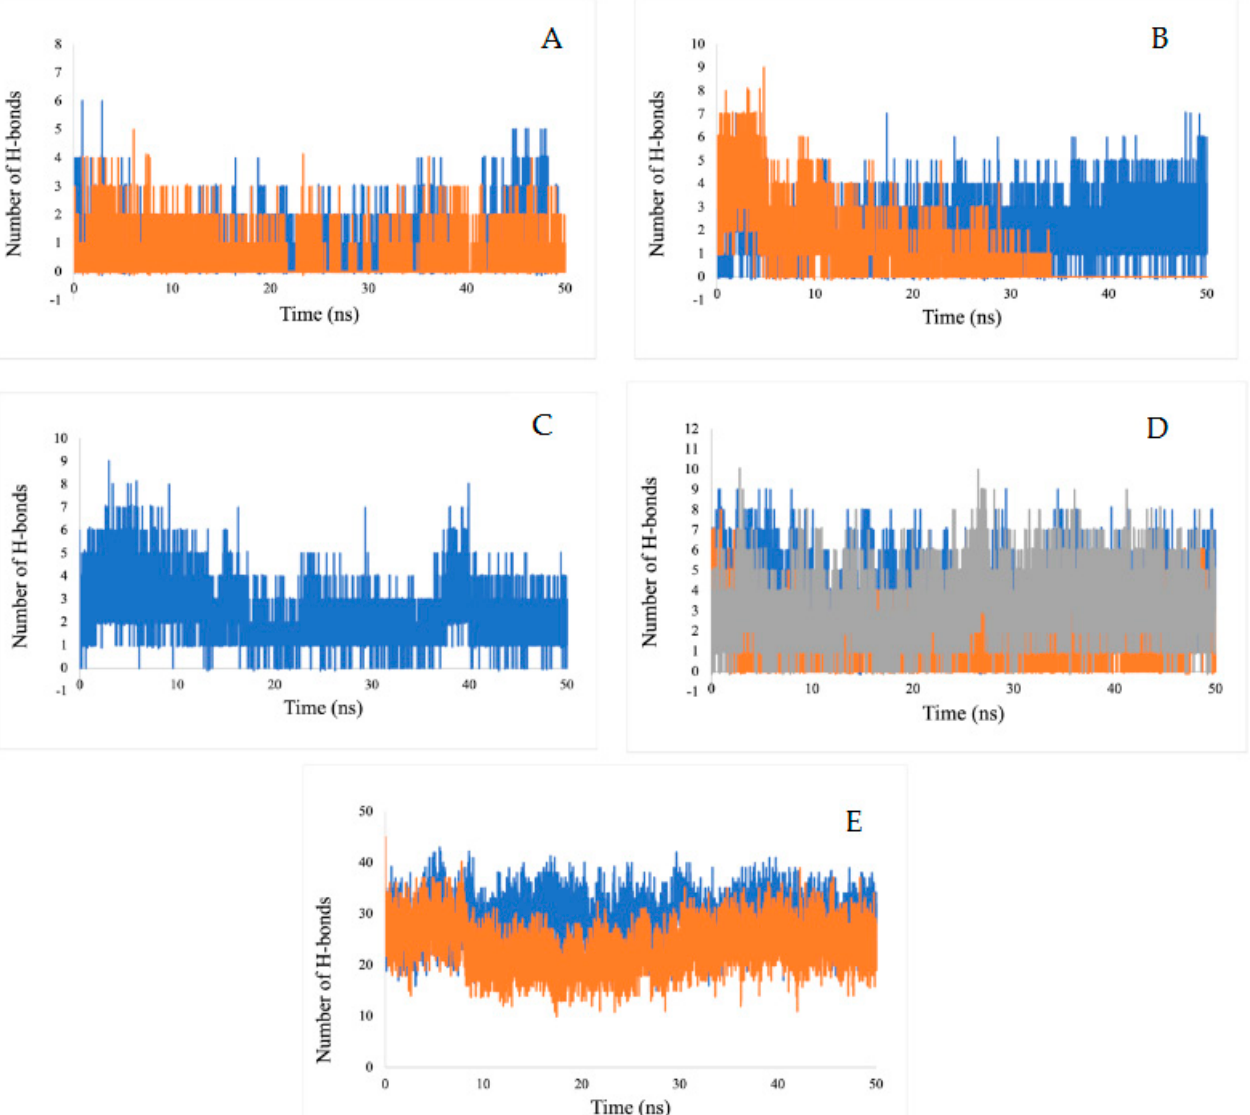
Figure 12. Estimation of the hydrogen bond number during a 50 ns MD simulation of for ( A ) actylcholine esterase, ( B ) actin, ( C ) α - tubulin, ( D ) arginine kinase, and ( E ) histone subunit III with inhibitors (disodium 5 ′ -inosinate and petunidin 3-glucoside), (calcium 5 ′ -guanylate D and chlgenic acid), chlorogenic acid, (kaempferol-3,7-di-O-glucoside I, hyperoside D, delphinidin 3-glucoside ID), and (myricetin 3 ′ -glucoside ID, hyperoside D) complexes.